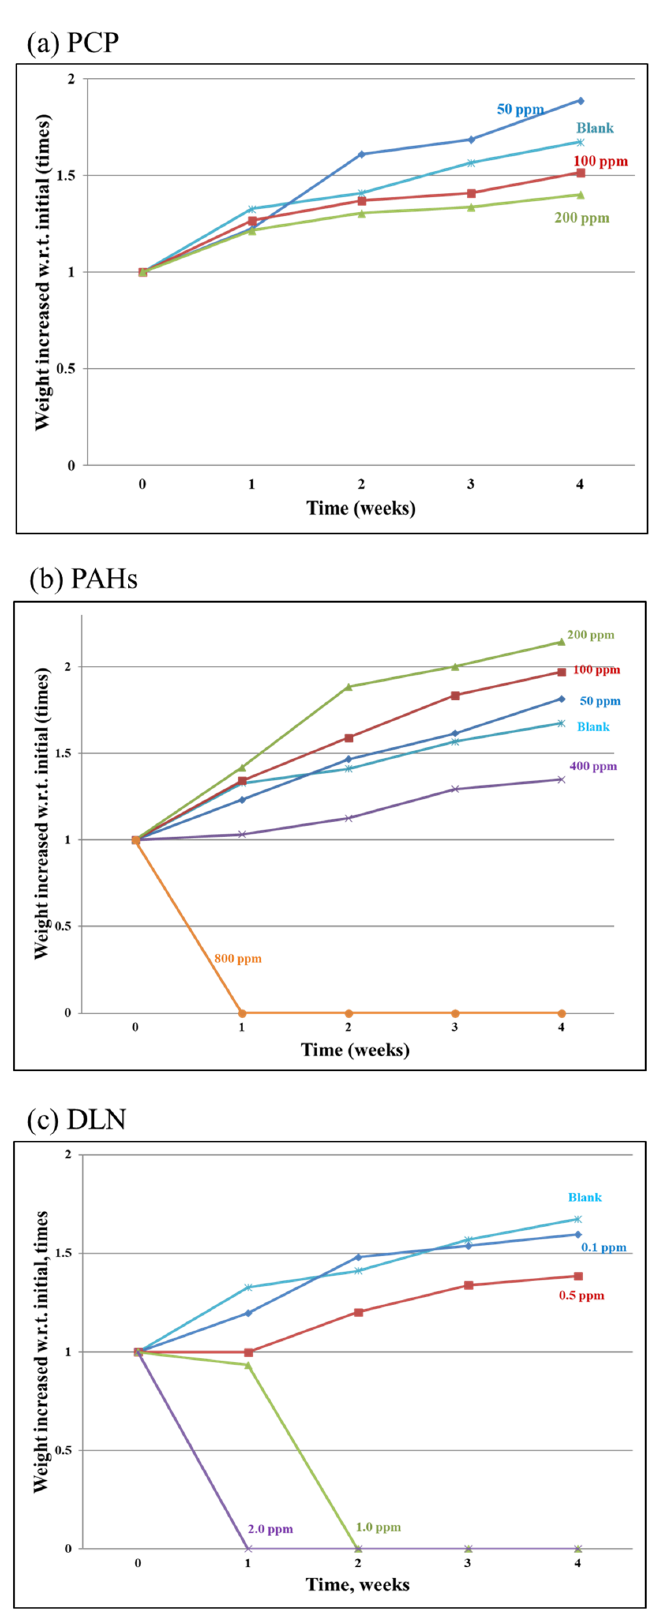
Figure 2. Increased larval weight with respect to its initial weight in the presence of the tested PCP, PAHs and DLN, as labeled in ( a – c ), respectively.